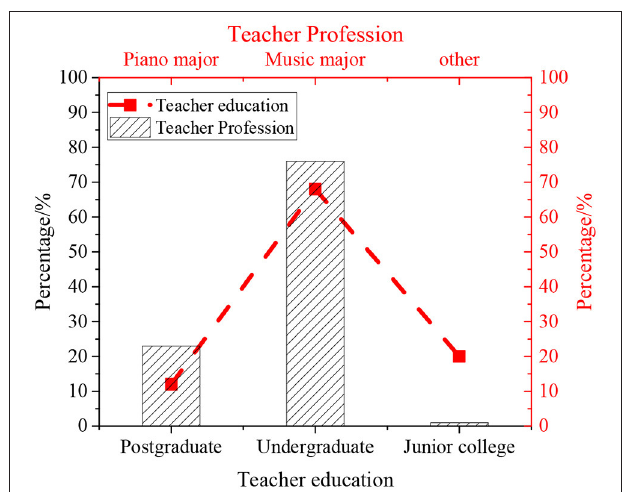
FIGURE 11 | QS result of